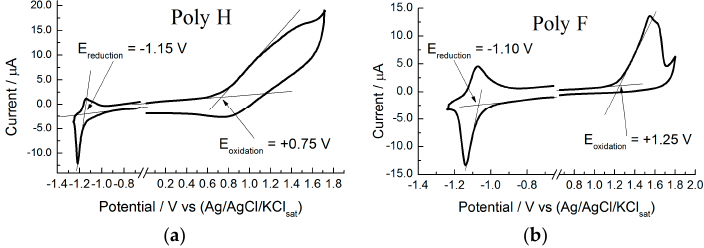
Figure 2. Cyclic voltametries ( a , b ) of the Poly H and Poly F polymer films on GC surfaces (obtained by drop-casting procedure), respectively. Showing the method adopted to determine the reduction and oxidation onset potentials, which are used to calculate the so-called electrochemical band gap ( ∆ E EC ). Onset values are obtained by the intercept of the lines interpolating the baseline and redox peak